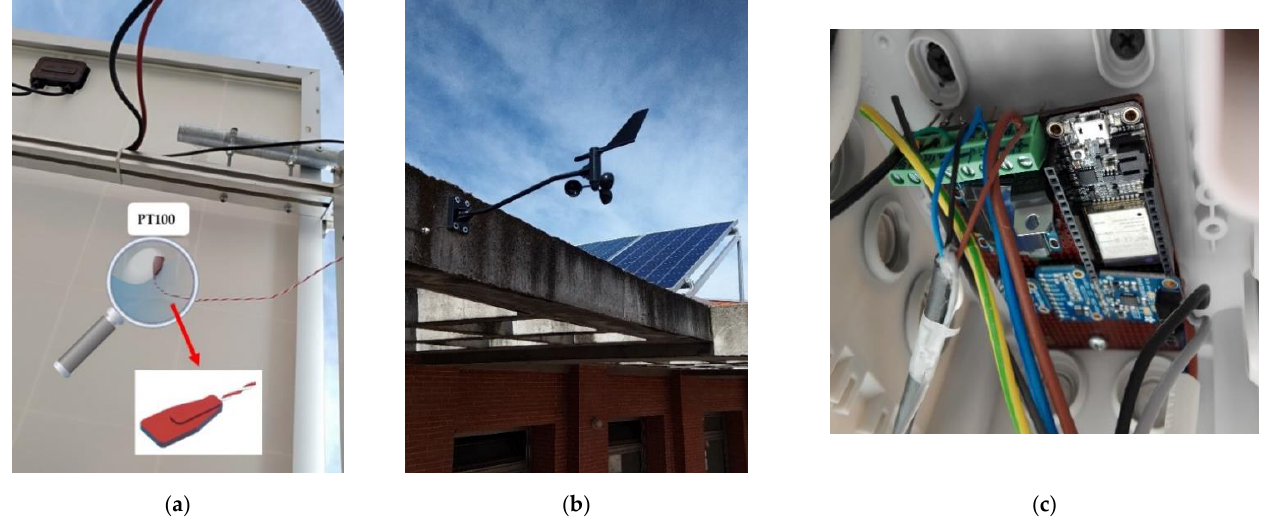
Figure 8. ( a ) Wireless weather station: PT100 fixed to the PV module, ( b ) anemometer and ( c ) the acquisition electronics.